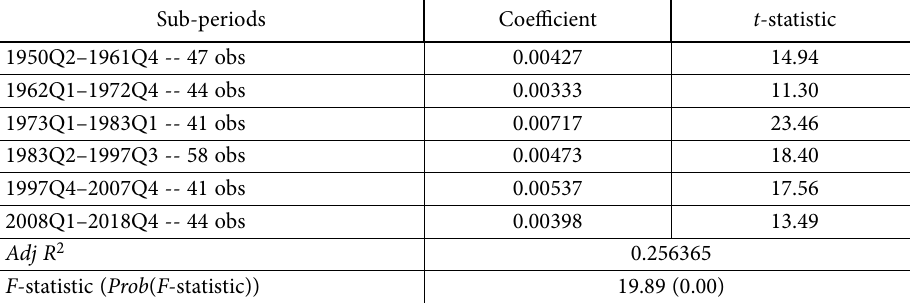
Table 5. Univariate estimation of STDEV via